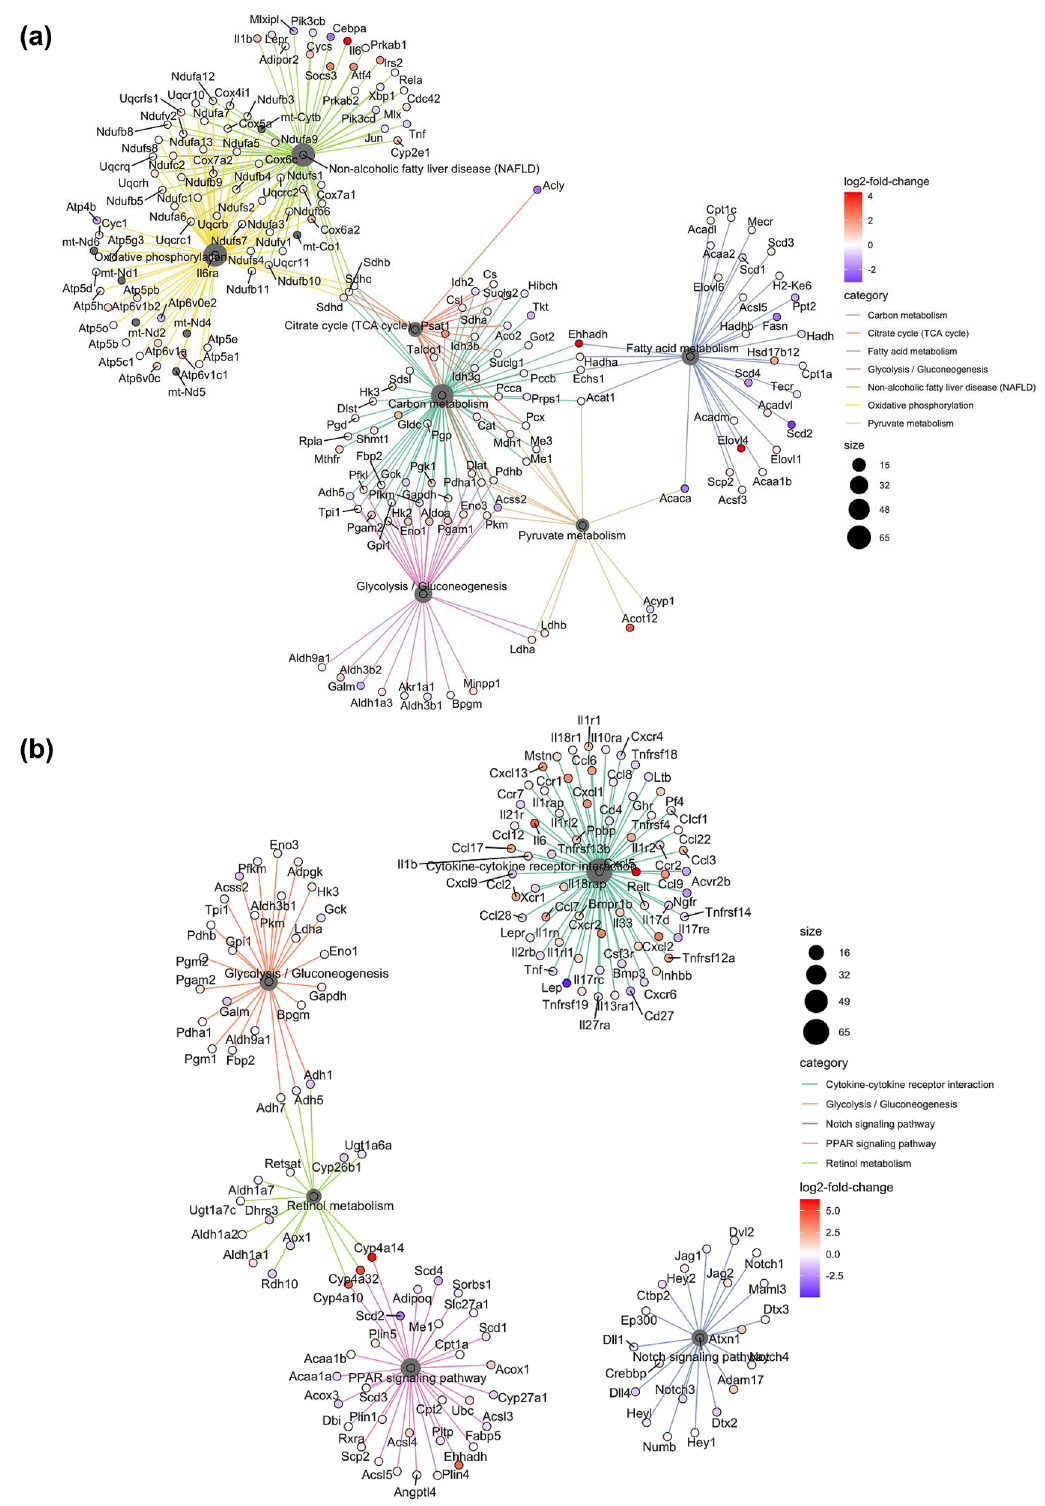
Figure 5. Afadin deletion modulates the transcriptomic profile within specific pathways regulating BAT function. ( a , b ) KEGG term—gene interaction plot depicting the linkages of genes and biological concepts (KEGG terms) as a network. Log2 fold changes (FAKO vs CTRL) of gene expression within selected enrichments at 29 °C ( a ) or at 5 °C ( b